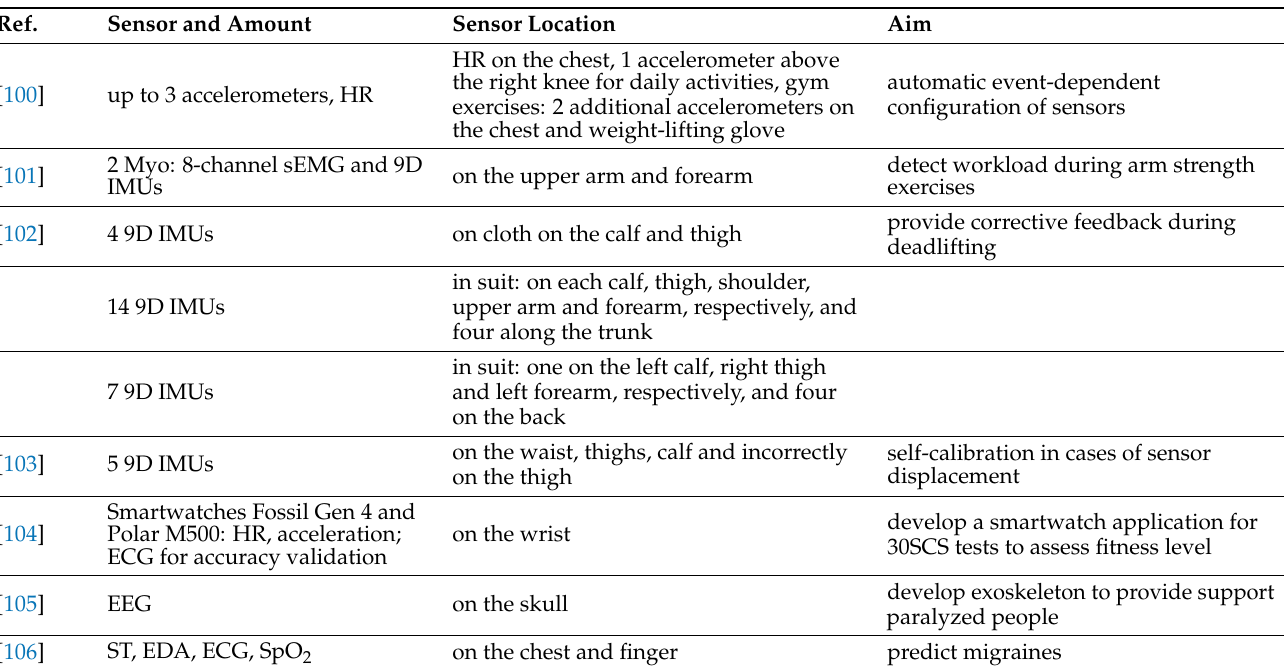
automatic event-dependent configuration of